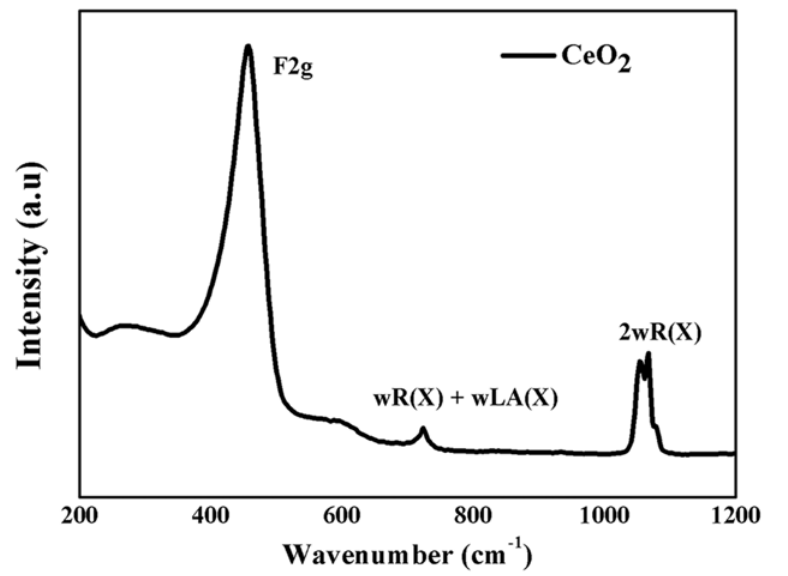
Fig 4. Raman spectrum of CeO 2 nanoparticles.